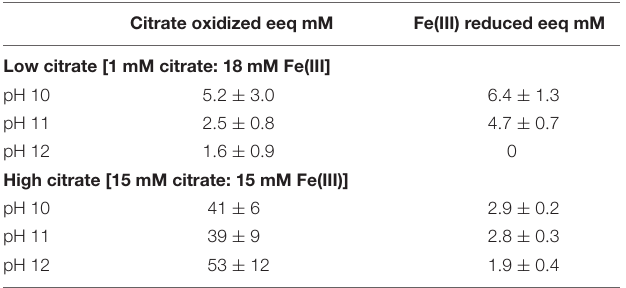
TABLE 1 | Electron balance assessment for Fe(III)-reducing